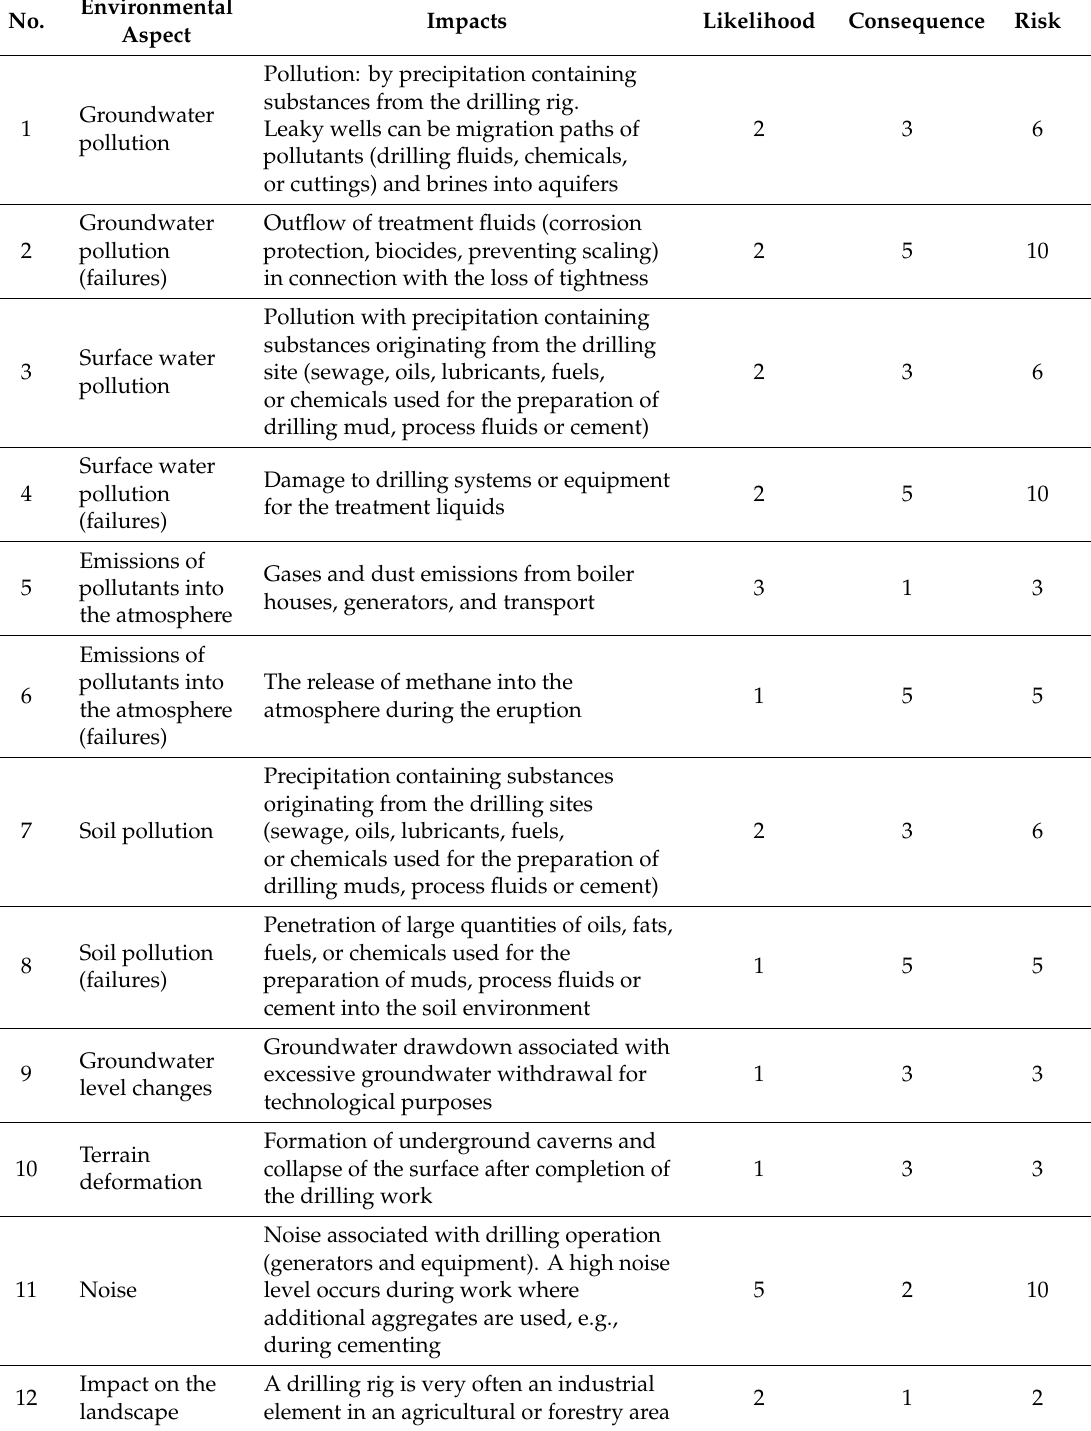
Table 1. Environmental impact and risk resulting from coalbed methane (CBM) exploration (drilling rig locations, drilling